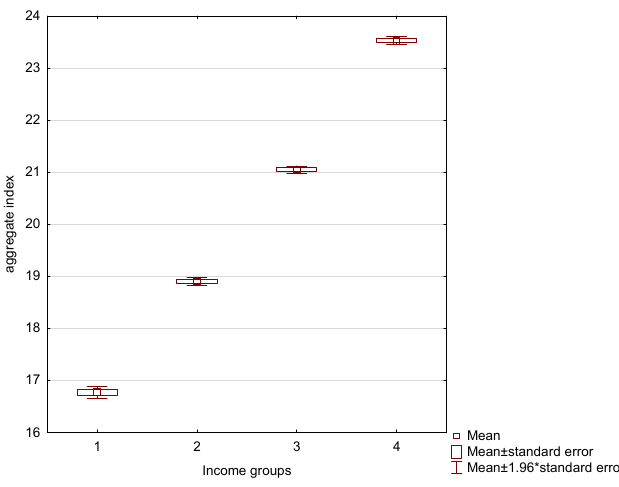
Figure 5. The level of the aggregate indicator in 2018 by income groups for households of people aged 60 and older Comment: the groups of households were divided into four equal groups. In the first quintile group, there were 1/4 of households with the lowest levels of disposable income. Source: own elaboration based on data from [136].